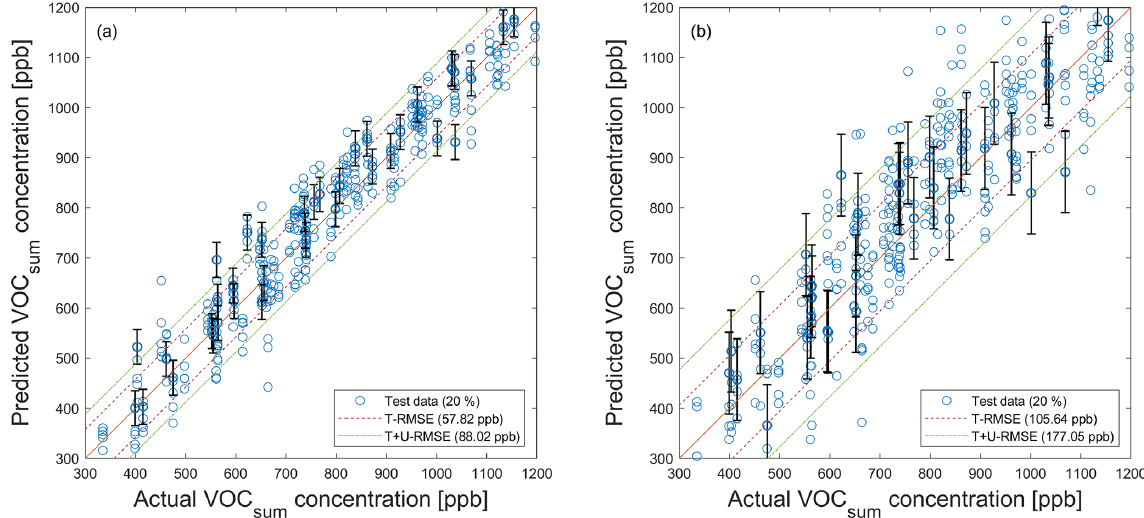
Figure A7. PLSR model (trained with noisy data; n comp = 20) applied to noisy test data (see Fig. 5) for the quantification of VOC sum using their associated standard uncertainty. (a) SNR = 55dB. (b) SNR = 40dB. Dashed red and green lines indicate the test RMSE (T − RMSE) and the test plus uncertainty RMSE (T + U − RMSE) based on test data, respectively. For better visibility, error bars are only shown for every 10th prediction.